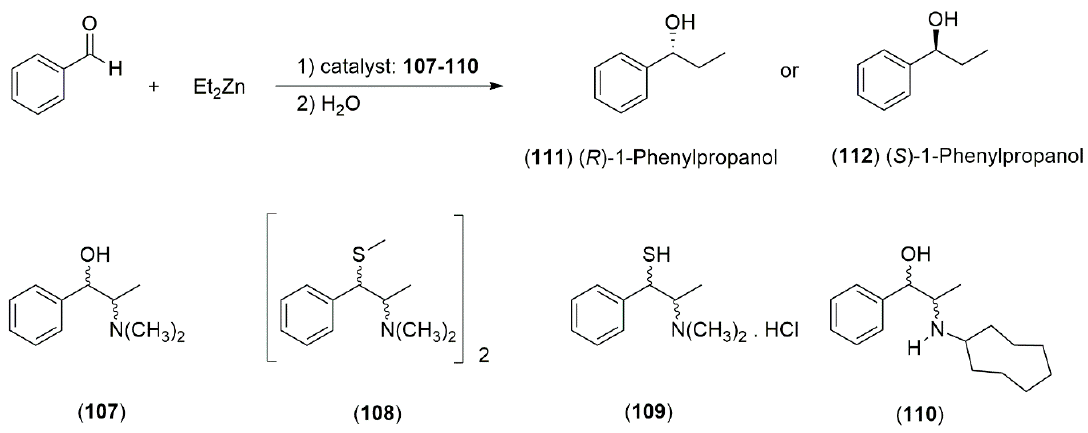
Figure 4. Ephedra -derived ligands as chiral, non-racemic templates for building a diverse array of ligands.